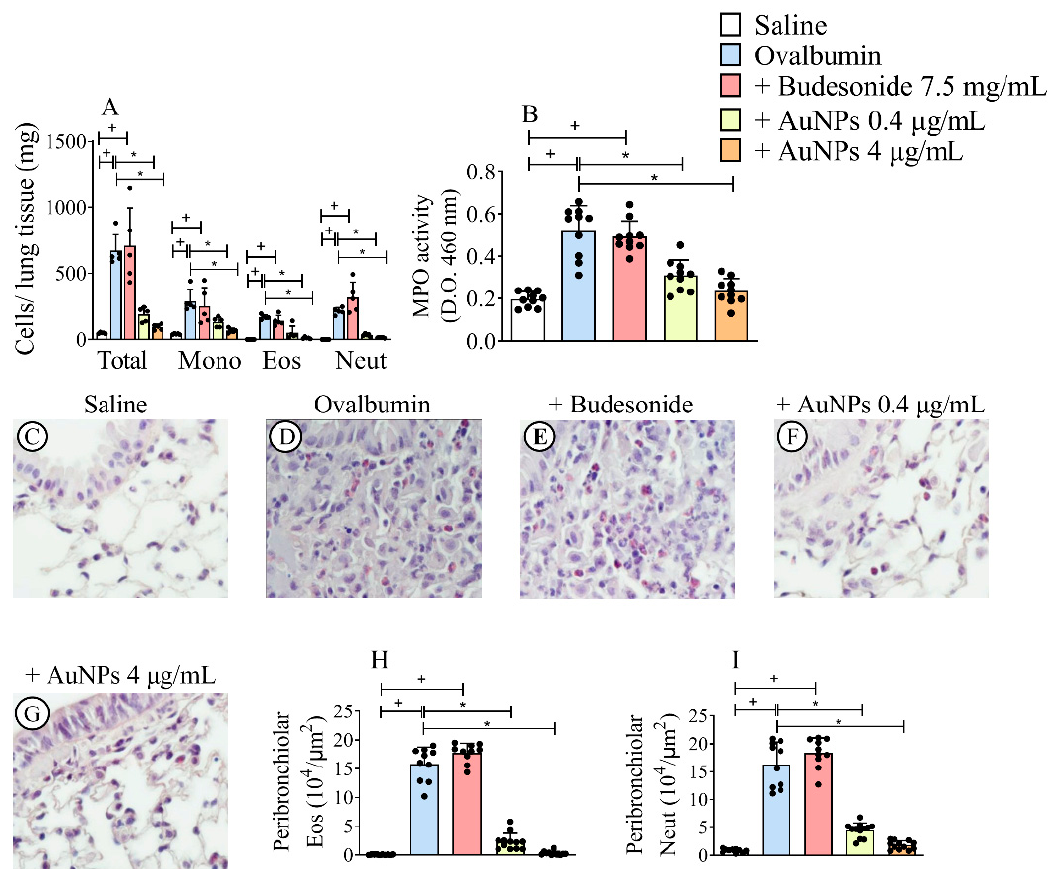
Figure 2. Effect of nebulized Budesonide or gold nanoparticles (AuNPs) on lung inflammation following the protocol of ovalbumin intranasal instillation given once a week for 9 weeks. Data shown represent changes in inflammatory cell numbers in lung tissue digests ( A ) and lung tissue myeloperoxidase (MPO) activity ( B ) 24 h after the last allergen challenge. Photomicrographs of paraffin-embedded Sirius Red–stained lung sections from ovalbumin-sensitized mice challenged with saline ( C ), challenged with ovalbumin ( D ), challenged with ovalbumin, and treated with Budesonide ( E ), challenged with ovalbumin and treated with either AuNPs (0.4 µ g/mL) ( F ) or AuNPs (4 µ g/mL) ( G ), respectively. The number of eosinophils (Eos) ( H ) and neutrophils (Neut) ( I ) in peribronchiolar regions was determined in Sirius Red-stained lung sections ( C – G ) by morphometric analyses. Data are expressed as mean ± SD (Each dot represents an individual mouse; n = 10 for all analyses except the one concerning changes in inflammatory cell numbers in lung tissue digests which has n = 5). + p < 0.05 as compared with the saline group, * p < 0.05 as compared with the ovalbumin-challenged group.